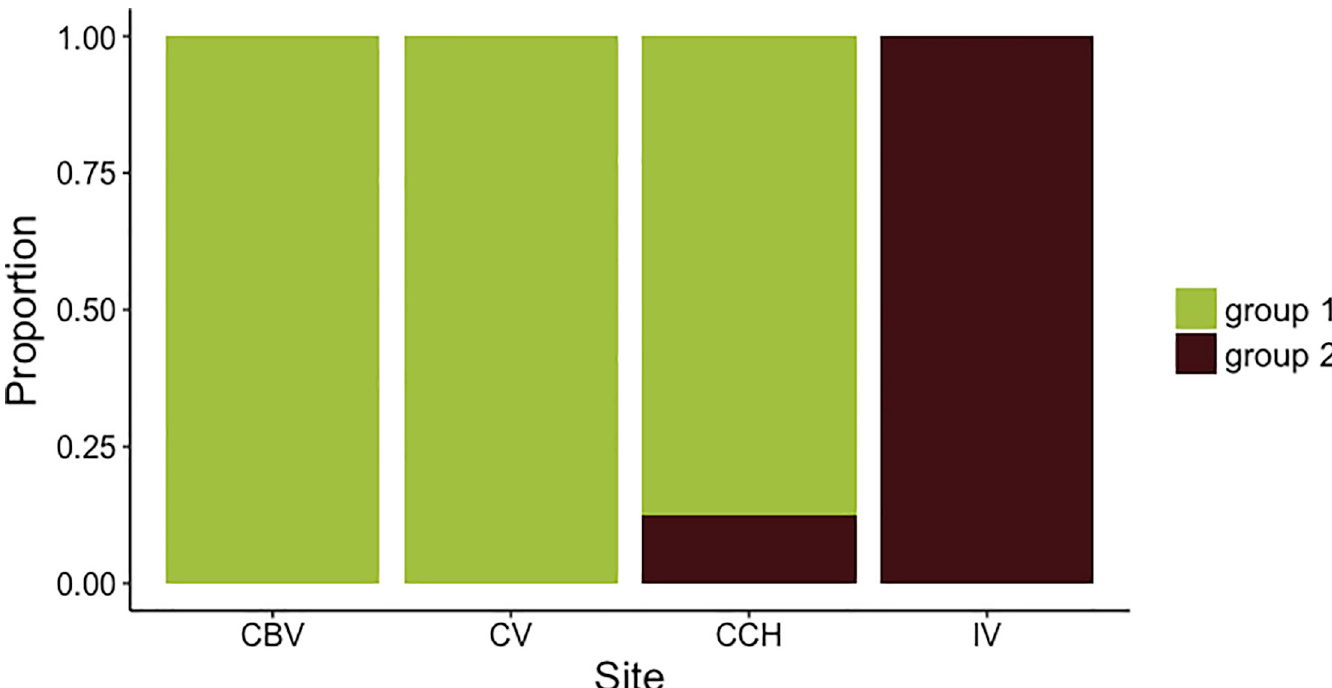
Fig 3. Group assignment for each timberline wren based on song dissimilarity. Males were assigned to one of the two groups based on the partitioning around medioids (PAM) function. CBV = Cerro Buena Vista, CV = Cerro Vueltas, CCH = Cerro Chirripo´, IV = Irazu´